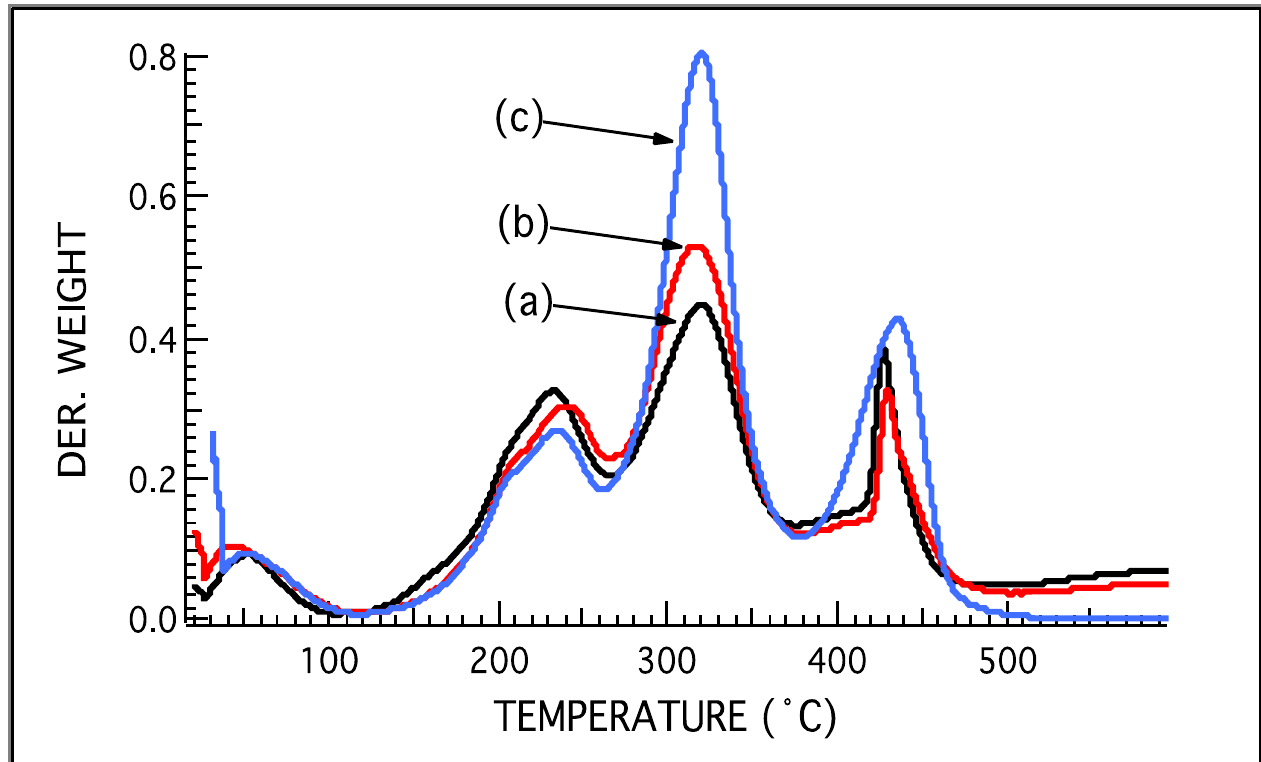
Figure 3. ( A ) Comparison of percent weight as a function of temperature for microcapsules with 22% free formaldehyde shell:core ratio 1:2 and varying water:oil ratios. (a) W:O = 4.5:1; (b) W:O = 5:1; (c) W:O = 5.5:1. ( B ) Comparison of derived weight as a function of temperature for microcapsules with 22% free formaldehyde shell:core ratio 1:2 and varying water:oil ratios. (a) W:O = 4.5:1; (b) W:O = 5:1; (c) W:O = 5.5:1.